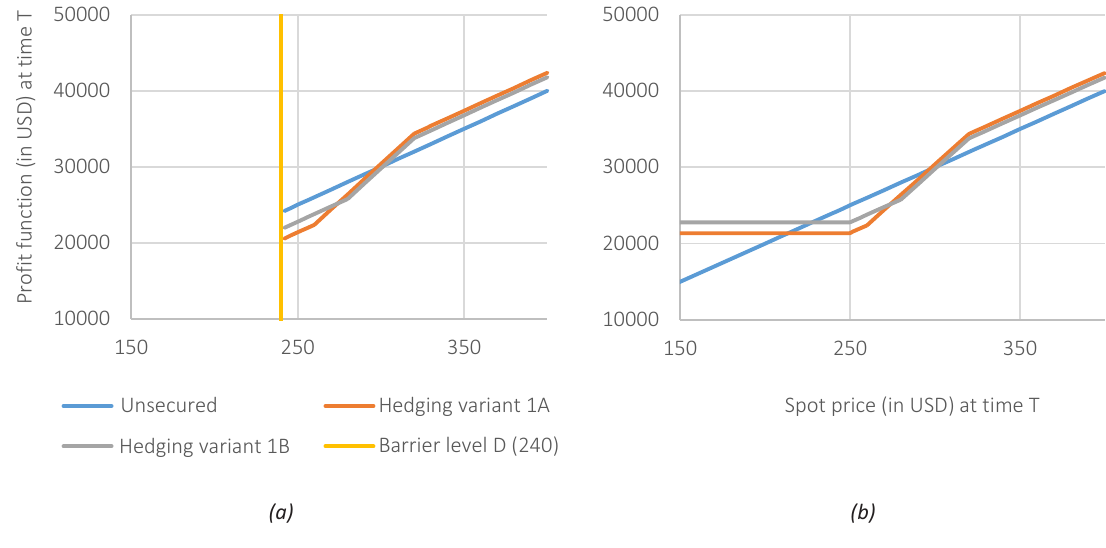
Figure 1. Comparison of the variants 1A and 1B with the unsecured